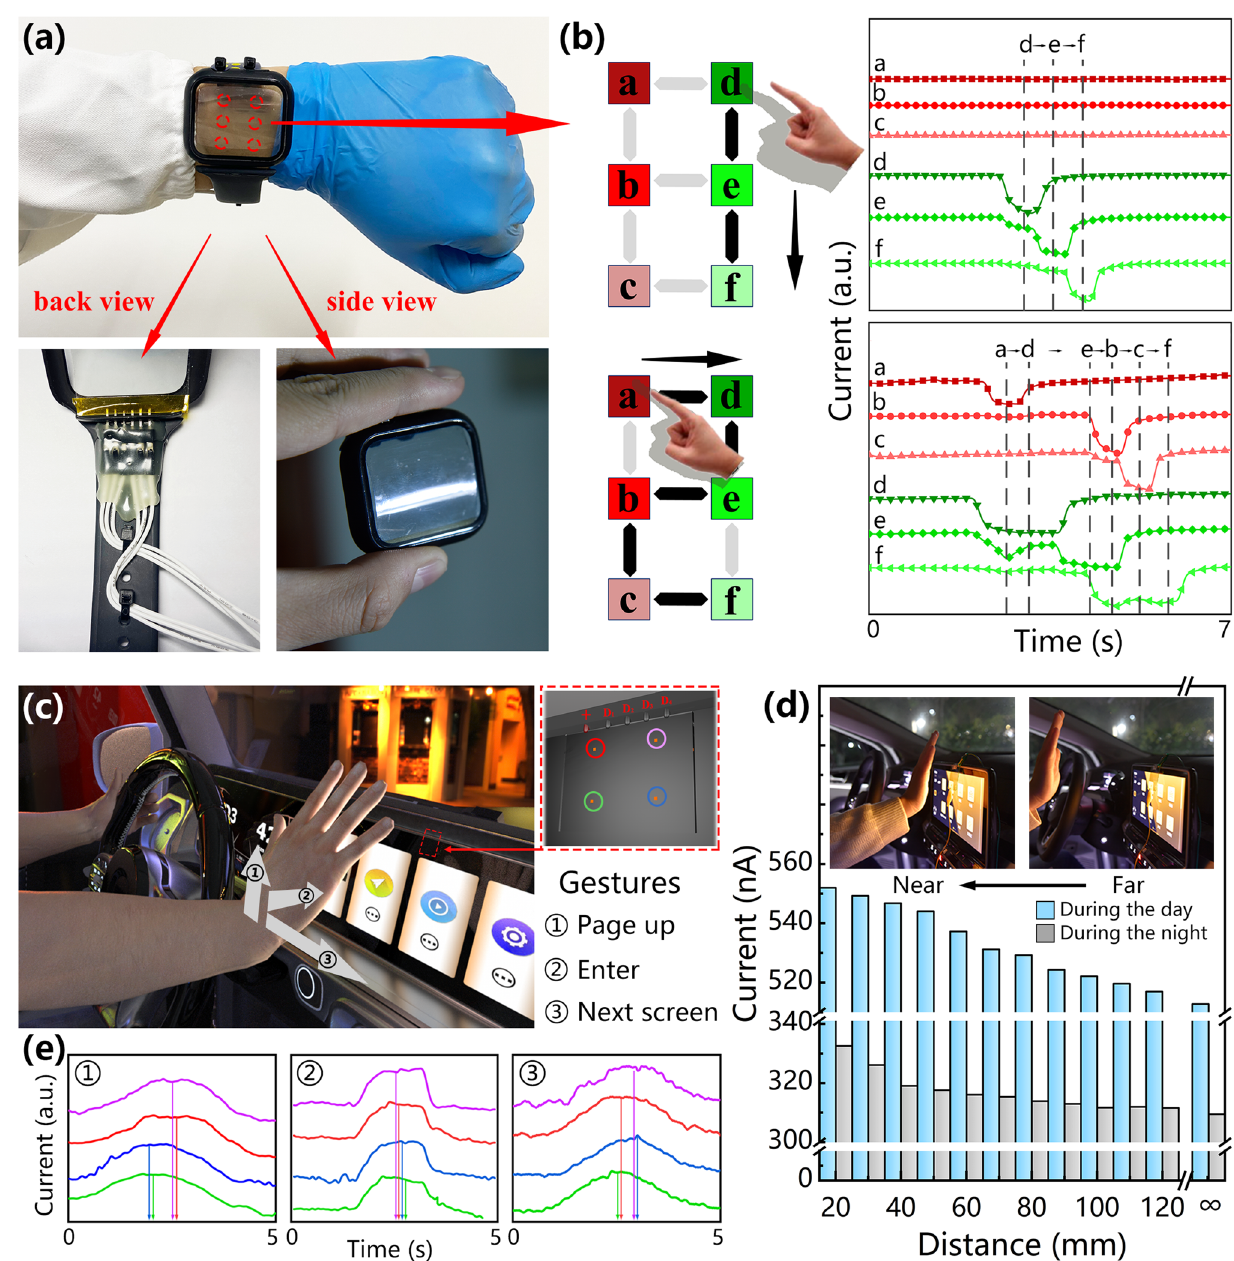
Fig. 5 Application of the SPR array for non-contact human–machine interaction in flexible wearable devices and integrated 3D gesture detec- tion. a The photograph of the flexible wearable device. b Gesture writing of the numbers “1” and “2” and the corresponding current. c The 3D gesture detection of the human–machine interface on the integrated car screen. d Schematic diagram of the detection mechanism of 3D motion detection and the current with the distance between the human hand and the display under a 5 V bias. e The current for different gestures at a 5 V